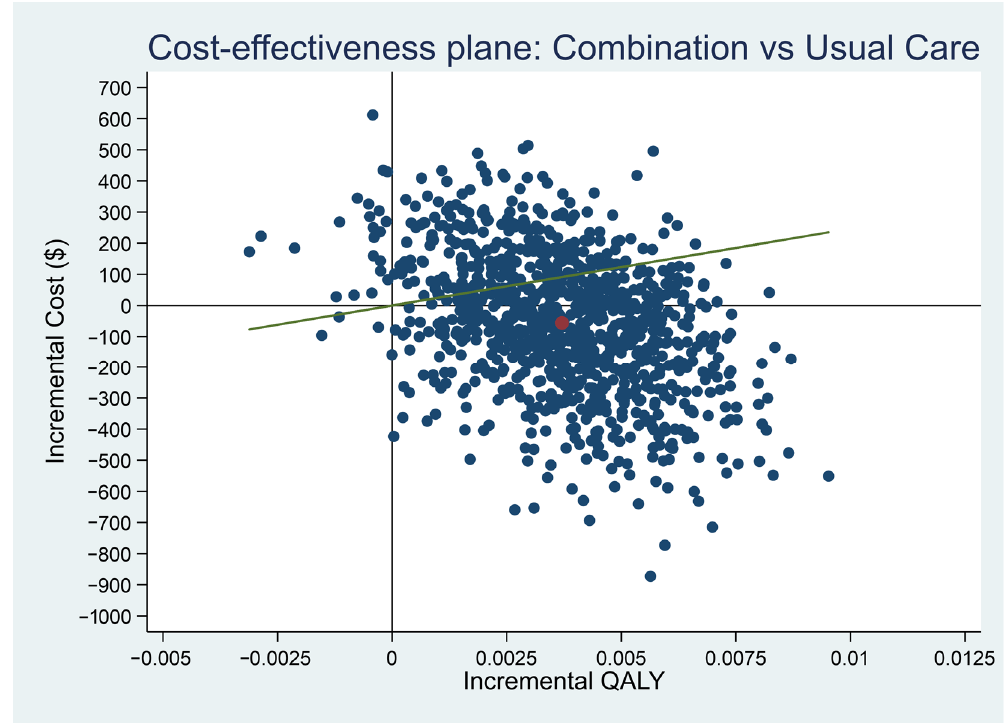
Figure 2. Cost–Effectiveness Plane (societal perspective). Red dot: Incremental cost-effectiveness ratio, Green line: willingness-to-pay